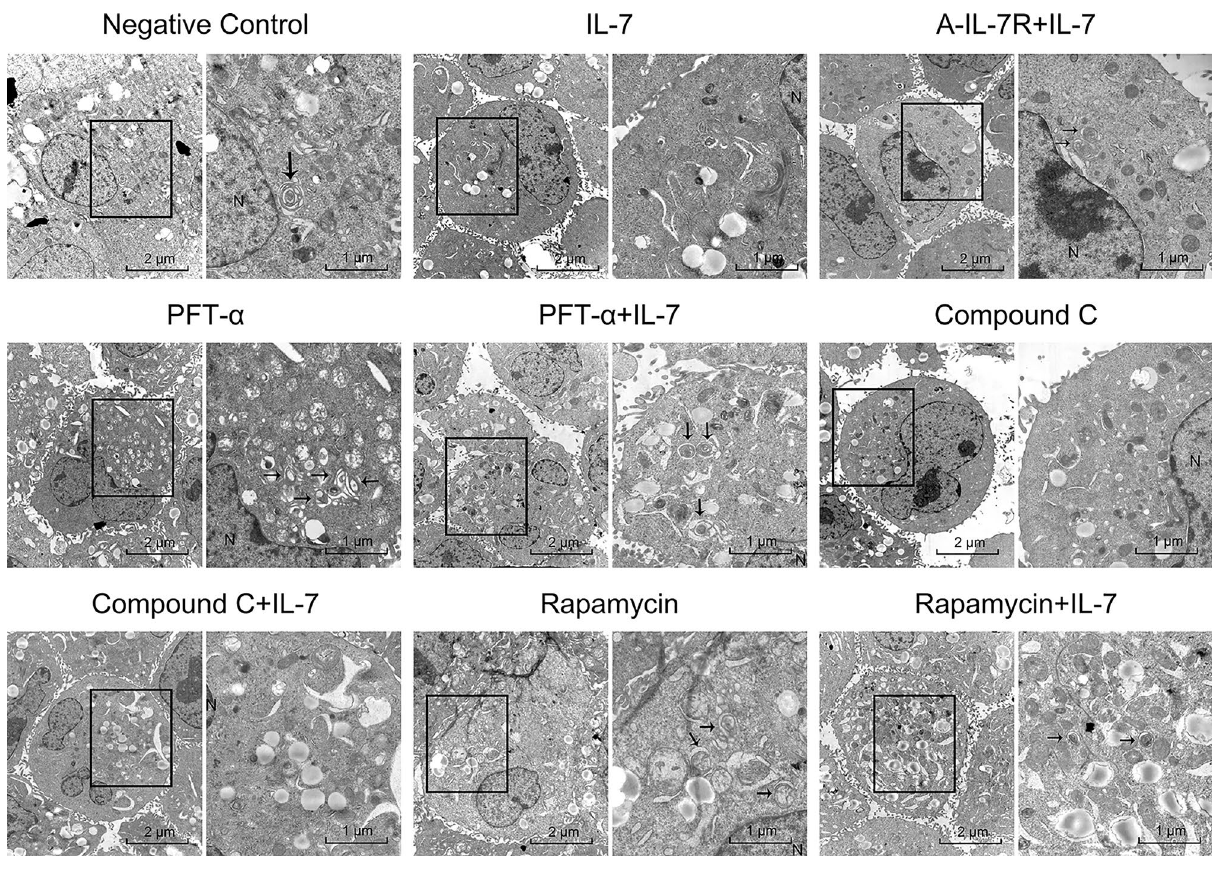
Figure 6. Transmission Electron Microscopy (TEM) results show the group as designed above. Images were taken at either 8000× or 20,000×. The 20,000× image was the enlarged image of 8000× in the black frame. In the 20,000×, the black arrow indicate characteristic autophagosome in A549 cells after treated with IL-7 (autophagosome decrease); cells treated with pifithrin ‐ α (autophagosome notably increase); cells treated with pifithrin ‐ α + IL-7 (autophagosome increase); cells treated with Compound C (autophagosome decrease); cells incubated with Compound C + IL-7 (autophagosome decrease); cells treated with A-IL-7R antibody + IL-7 (effect of IL-7-induced autophagosome depression was blunt); cells incubated with Rapamycin (autophagosome increase) and cells treated with IL-7 + Rapamycin (autophagyosome slightly